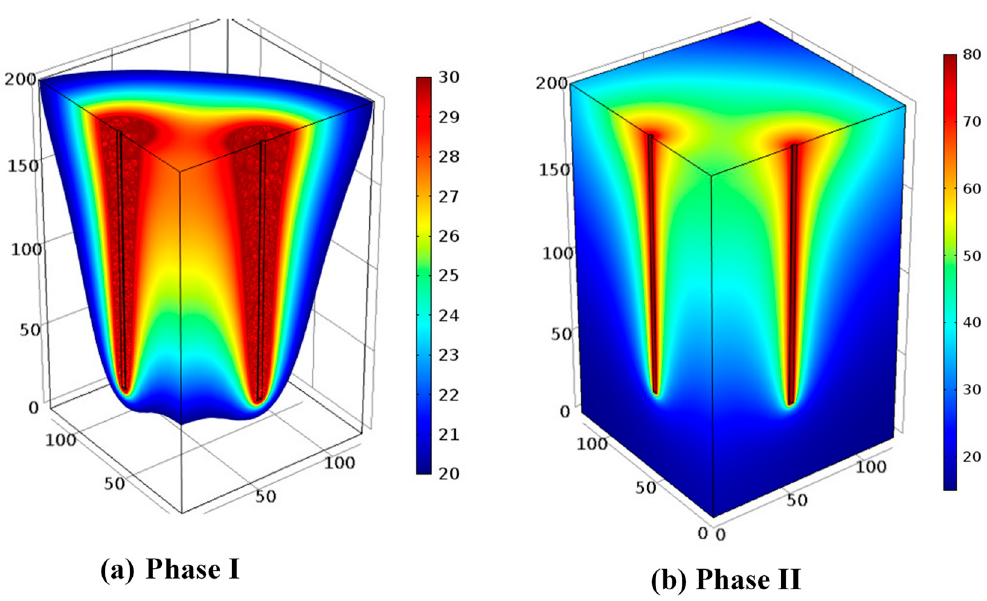
Figure 4. Temperature ( ◦ C) distribution in the domain after 4 days for ( a ) remediation phase and ( b ) storage phase. For the remediation phase, the part of the domain that has a temperature between 20–30 ◦ C is shown. Only a quarter of the domain is presented.